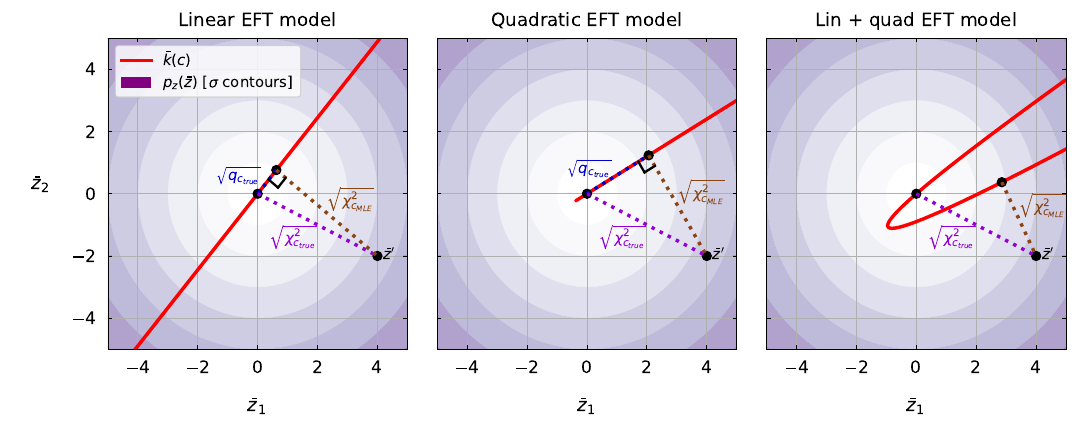
Figure 20: Visualisation showing how q ¯ z ′ . The test-statistic behaves like a χ 2 random variable for linear and quadratic mod-